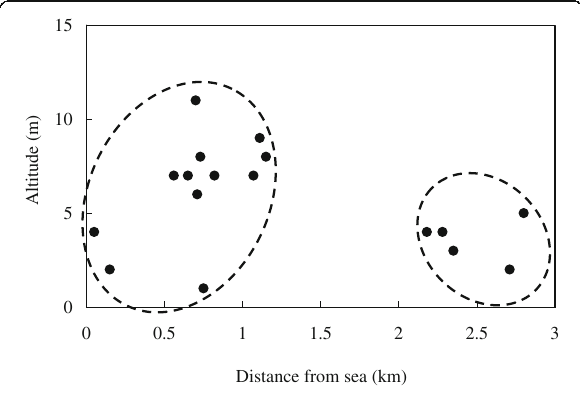
Fig. 10 Relationship between altitude and distance from sea. Data include all sake breweries operating in the study region in